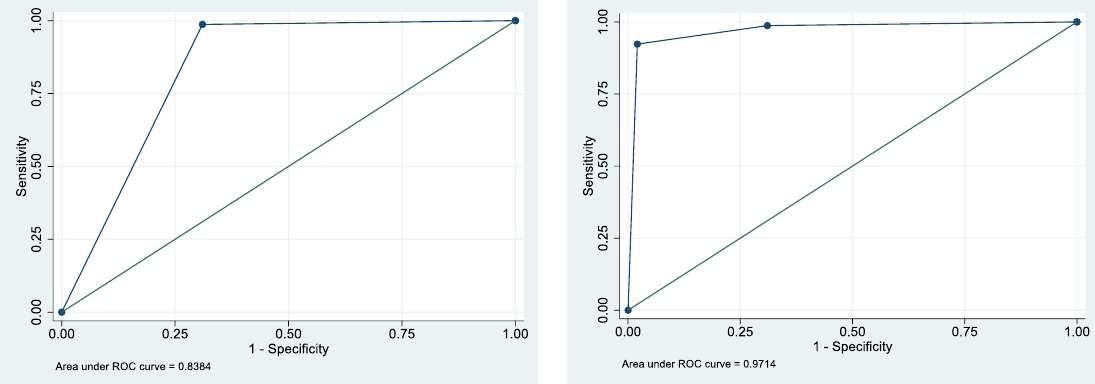
Figure 5. ROC (receiver operating characteristics) curves for cytological examination ( left ) of the cells and DNA image cytometry ( right ).